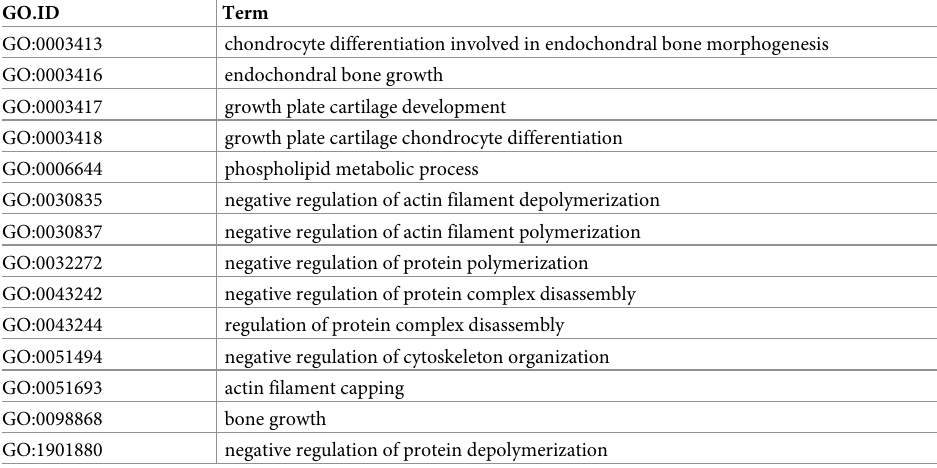
Table 6. BP GO term shared between LN/L6 and LNL1/LNH1 analyses. GO.ID